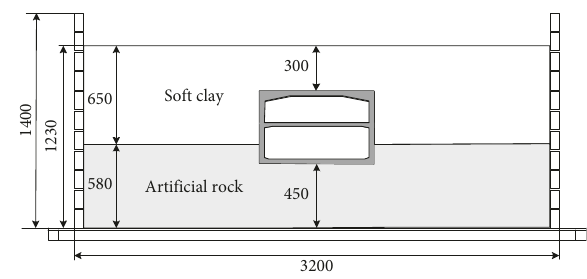
Figure 6: Layout of the model soil (unit: mm).